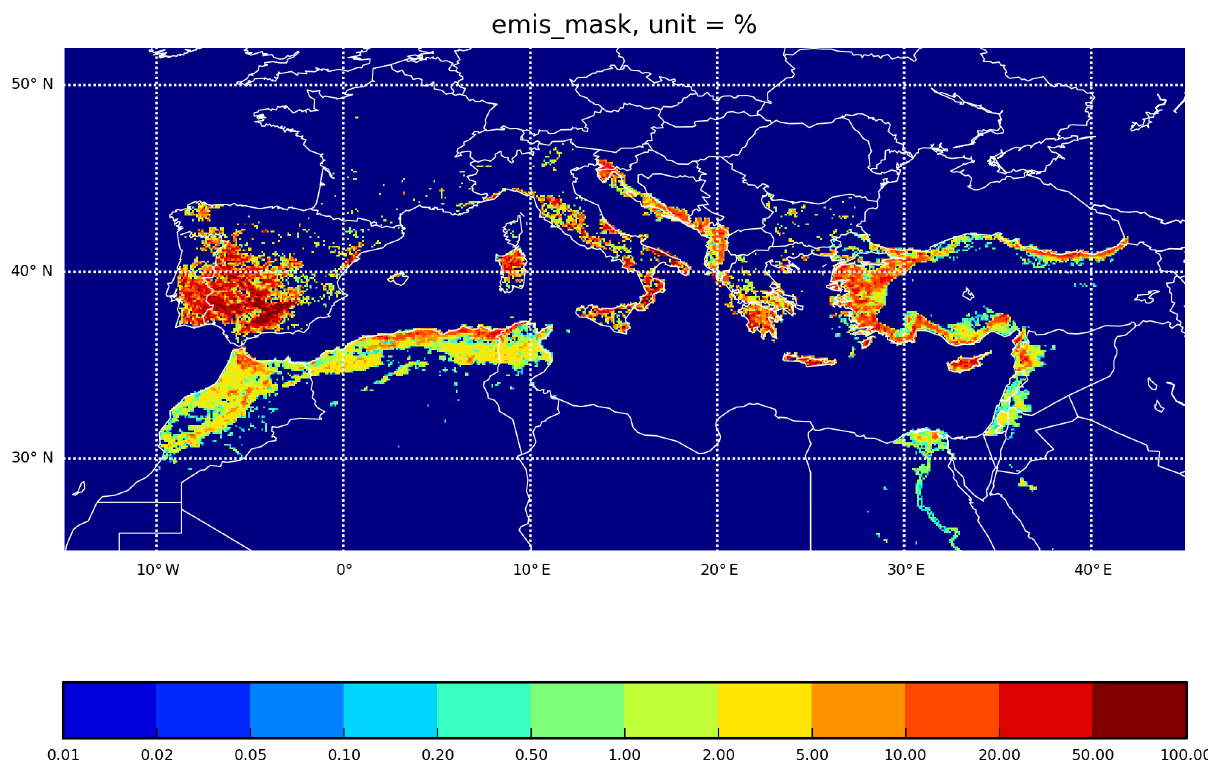
Figure 1. Olive habitat map, showing the percentage of the area occupied by the trees [%]. Productivity of an area with 100% olive coverage is assumed to be 10 10 pollen grain m − 2 season − 1